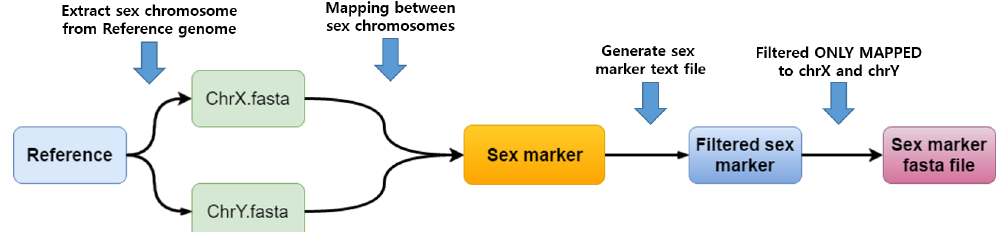
Fig 1. Procedure for extracting sex-specific markersequences. Two sex chromosomeswere alignedwith each other using LASTZ, and syntenic regions with polymorphisms were extracted. Final sex-specific marker sequenceswere selectedafter removalof similar sequences(90% identity by